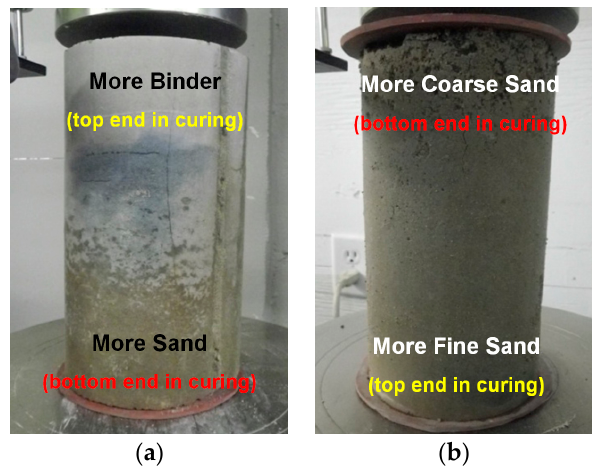
Figure 10. Observed segregations in cemented hydraulic backfill samples.